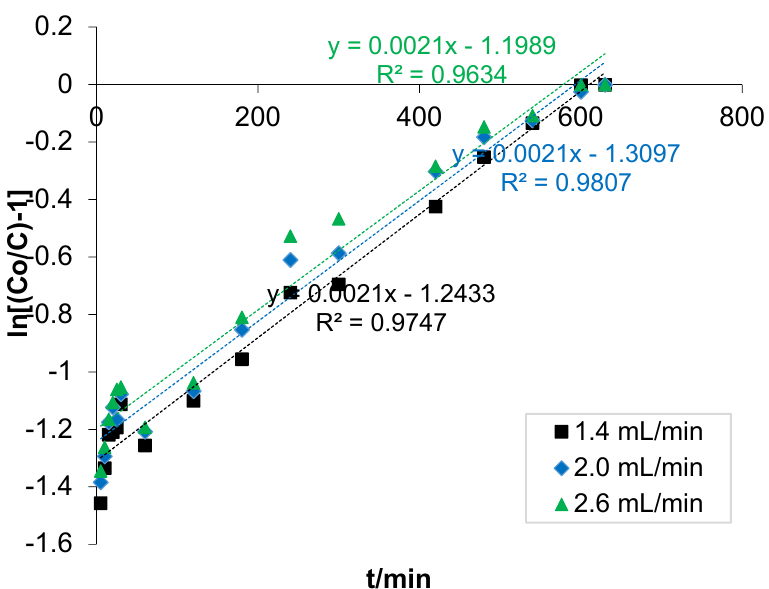
Figure 5. Linear plot of the Adam–Bohart model.